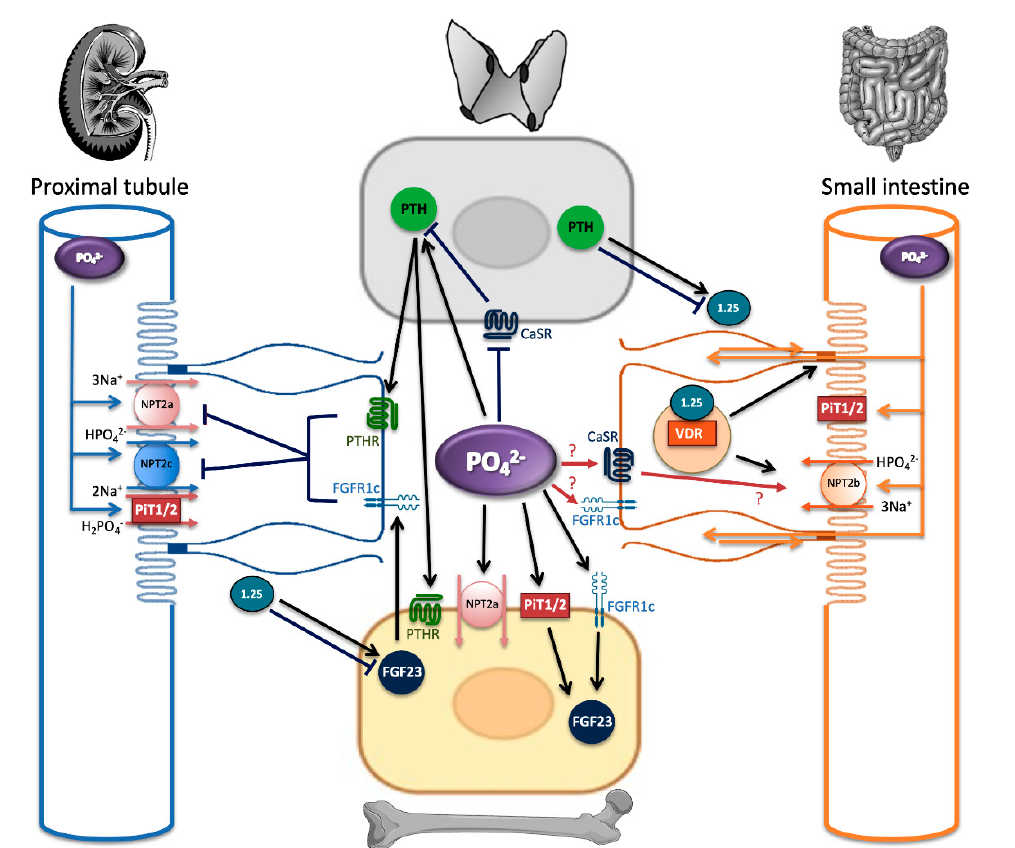
Figure 1. Phosphate homeostasis involves four organs, which interact via the action of the hormones PTH, FGF23, and calcitriol. Osteocytes and osteoblasts secrete FGF23, while proximal tubular cells convert inactive 25(OH) 2 vitamin D to active calcitriol via the action of the enzyme 1 alpha-hydroxylase [3]. These endocrine hormones regulate the expression and function of tissue-specific phosphate transporters. Extracellular phosphate can also directly act on the putative phosphate sensors, CaSR, PiT2, and FGFR1c to control these processes. Abbreviations: 1.25: 1.25(OH) 2 vitamin D, PIT1/2: PiT 1 and PiT2, VDR: vitamin D receptor. Red arrows with question marks indicate potential pathways.